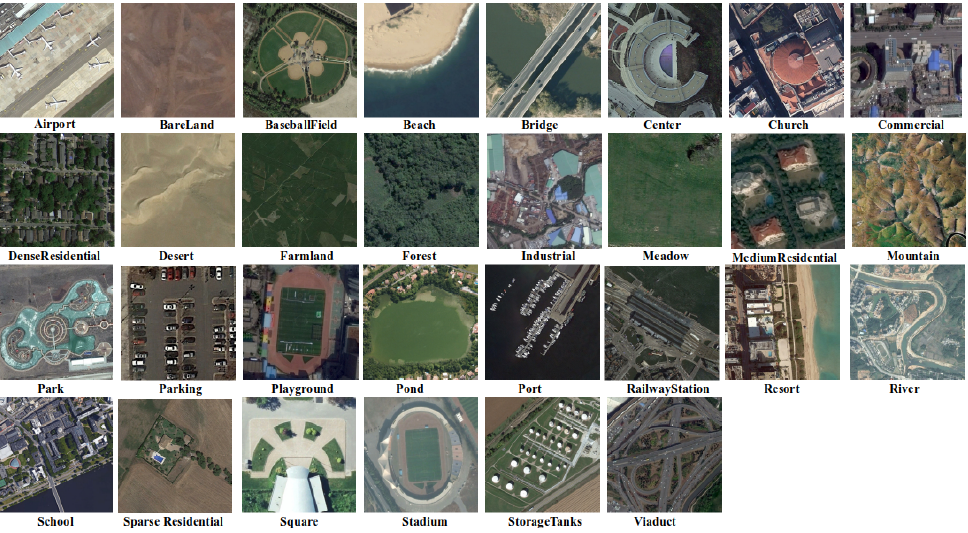
Figure 3. Example images associated with 30 land use classes in the AID data